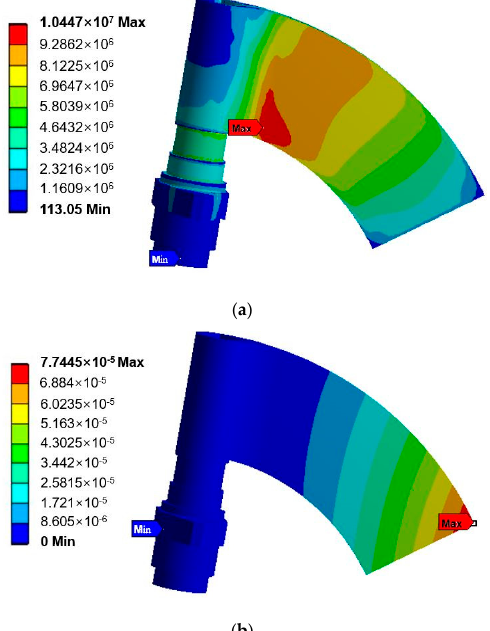
Figure 7. Fatigue critical detail. ( a ) Von Mises stress (Pa); ( b ) deformation (m).